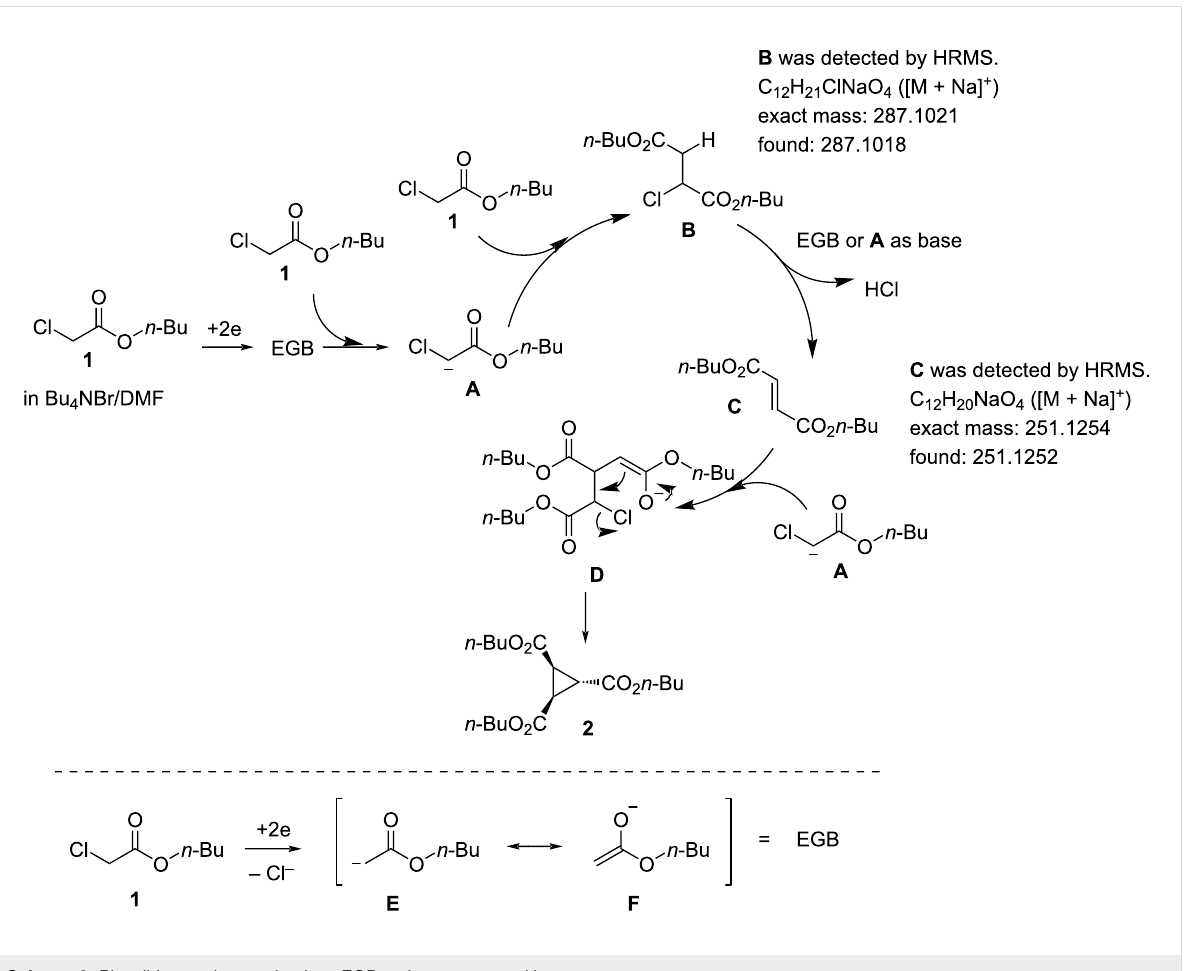
Scheme 2: Plausible reaction mechanism. EGB = electrogenerated base.